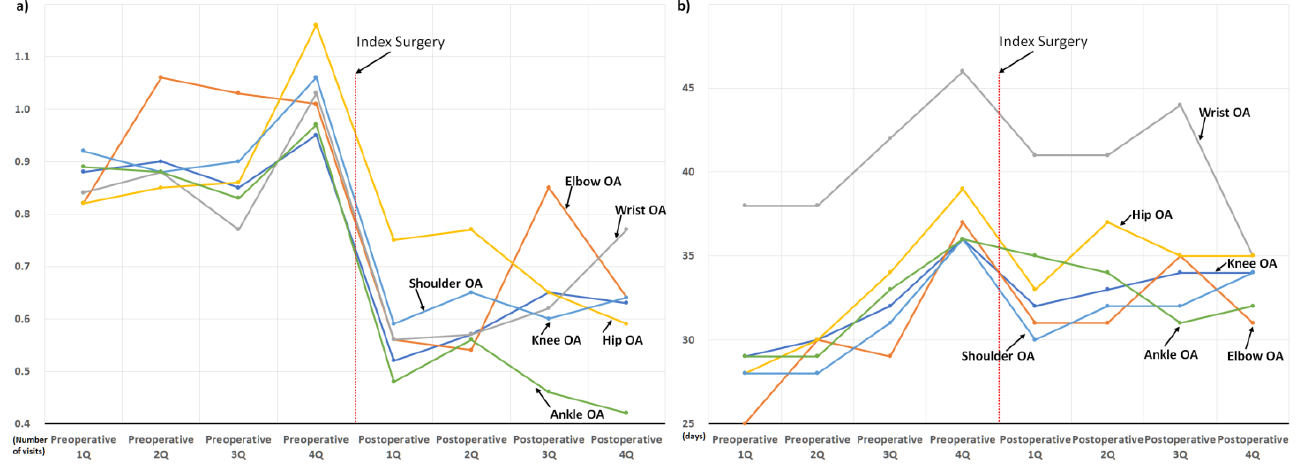
Figure 9. Perioperative changes in the use of sleep medication and hospital visits owing to sleep disorder according to the osteoarthritis of the extremities: ( a ) changes in the number of hospital visits, and ( b ) changes in the prescribed duration of sleep medication.